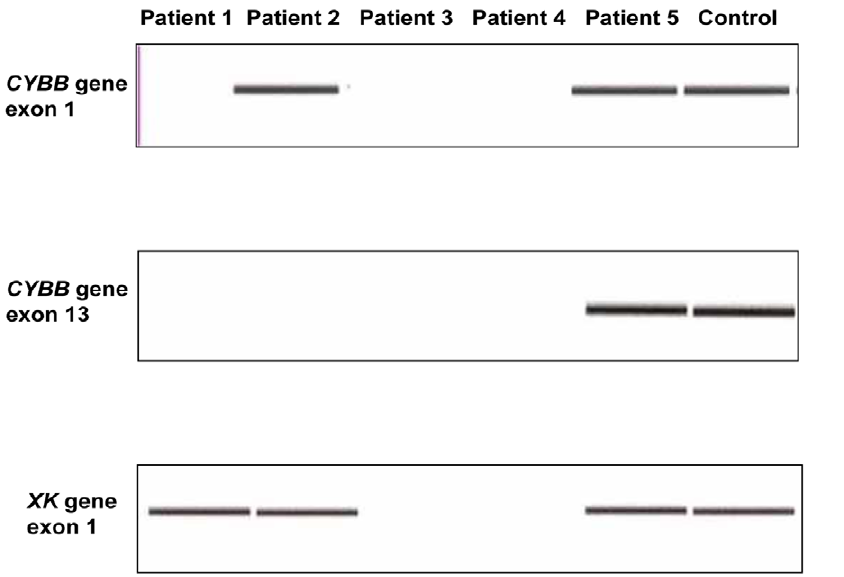
Figure 1. PCR Amplification Results for Exons 1 and 13 of the Chronic Granulomatous Disease Gene CYBB and Exon 1 of the McLeod Syndrome Gene XK Region. The analysis used the Agilent 2100 Bioanalyzer. Patients 1 to 5 were juvenile patients with chronic granulomatous disease, and genes from normal boys were amplified as a control. CYBB exon 1 was detected only from patients 2 and 5, and CYBB exon 13 only from patient 5. In addition, XK exon 1 was detected in patients 1, 2 and